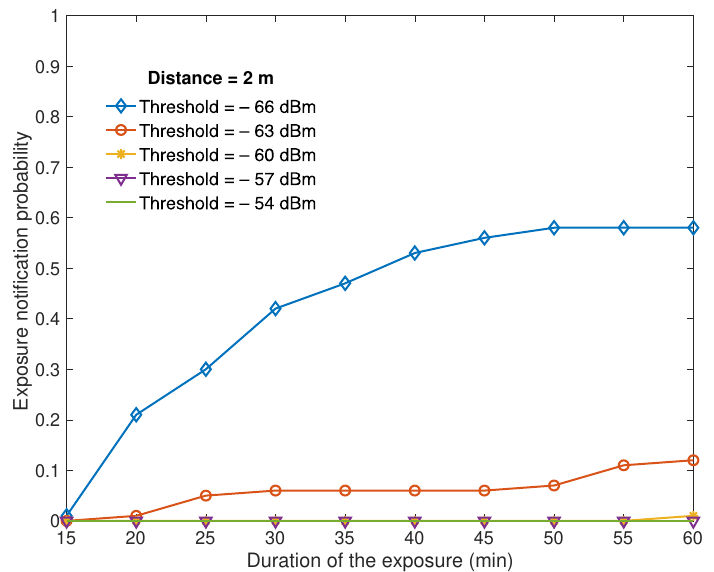
Figure 7. The probability of exposure notification vs. the duration of the exposure at a proximity detector for a beaconing tag at a distance of 2